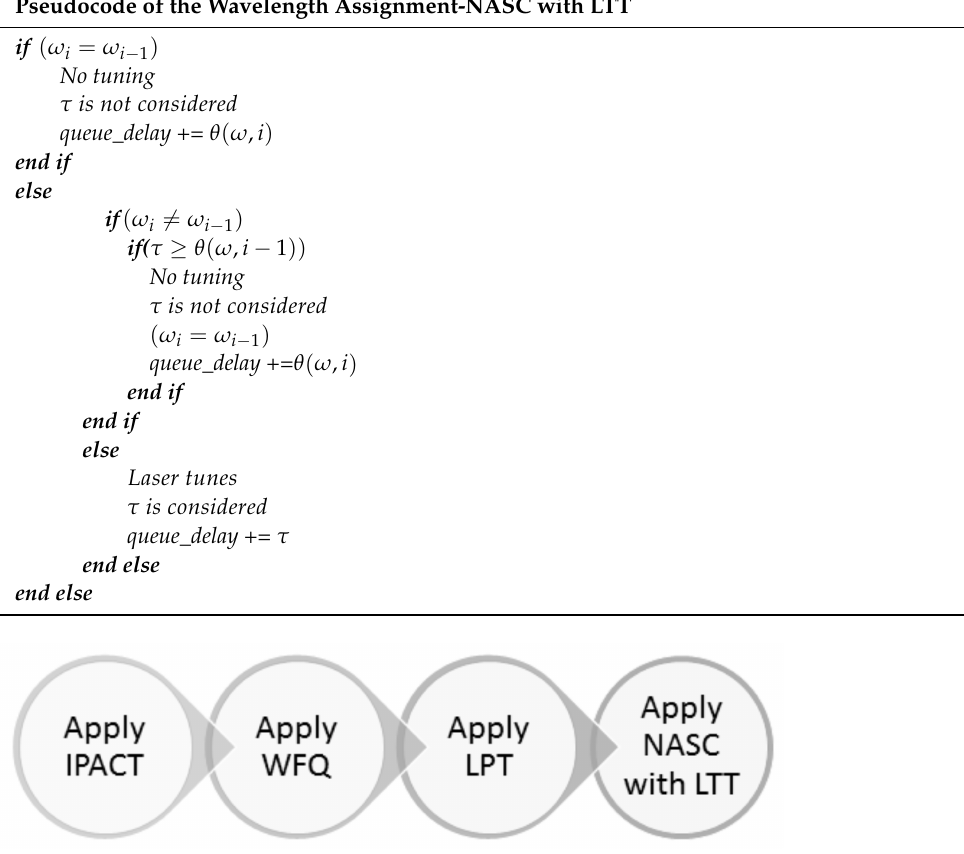
Figure 1. WFQLPT DBA algorithm sequence